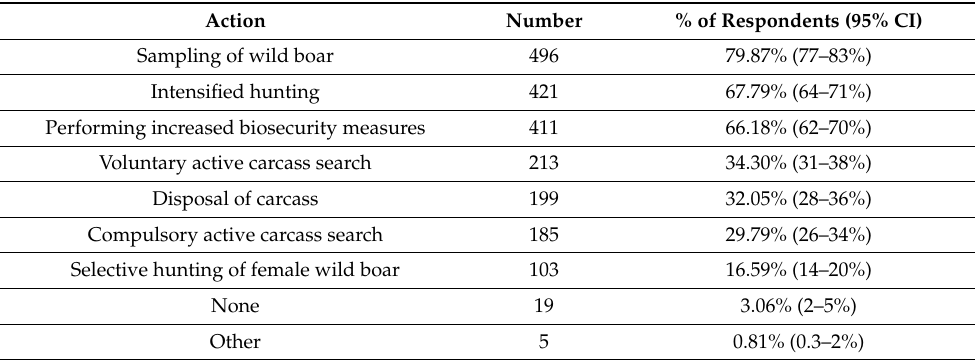
Table 2. ASF control actions in which respondents to an anonymous questionnaire amongst Lithuanian hunters had taken part